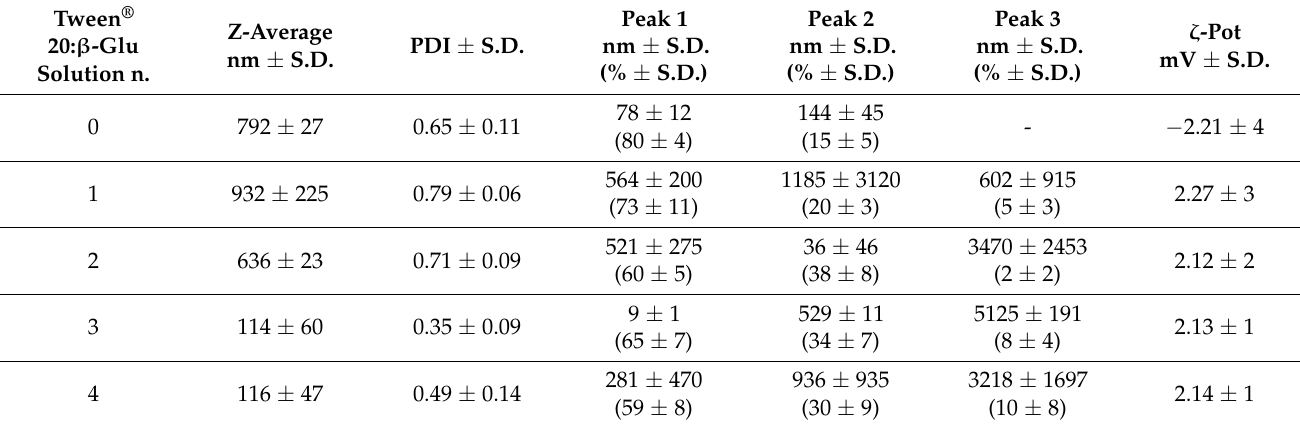
Table 3. Characteristics of Tween ® 20: β -Glucosidase